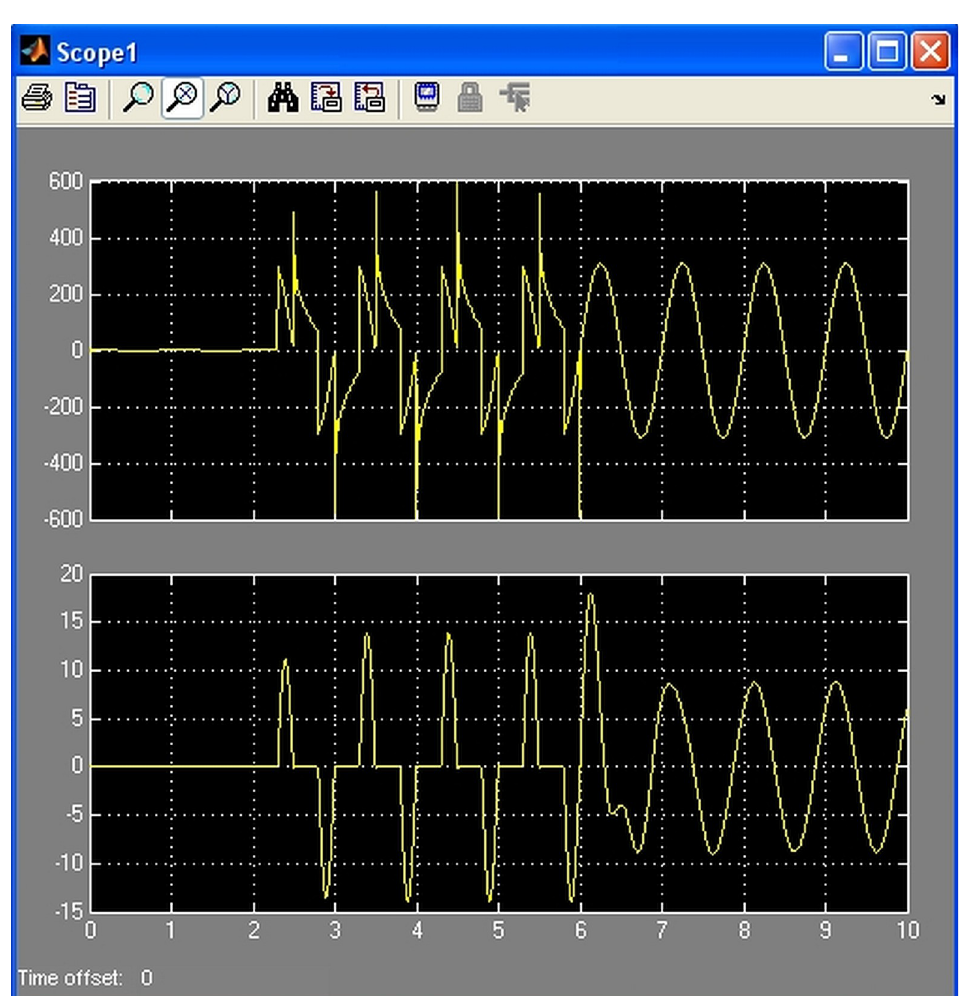
Fig 7. Simulation showing load coupling with variable triac firing angle. Voltage (up) and current (down) load variations for a RLC